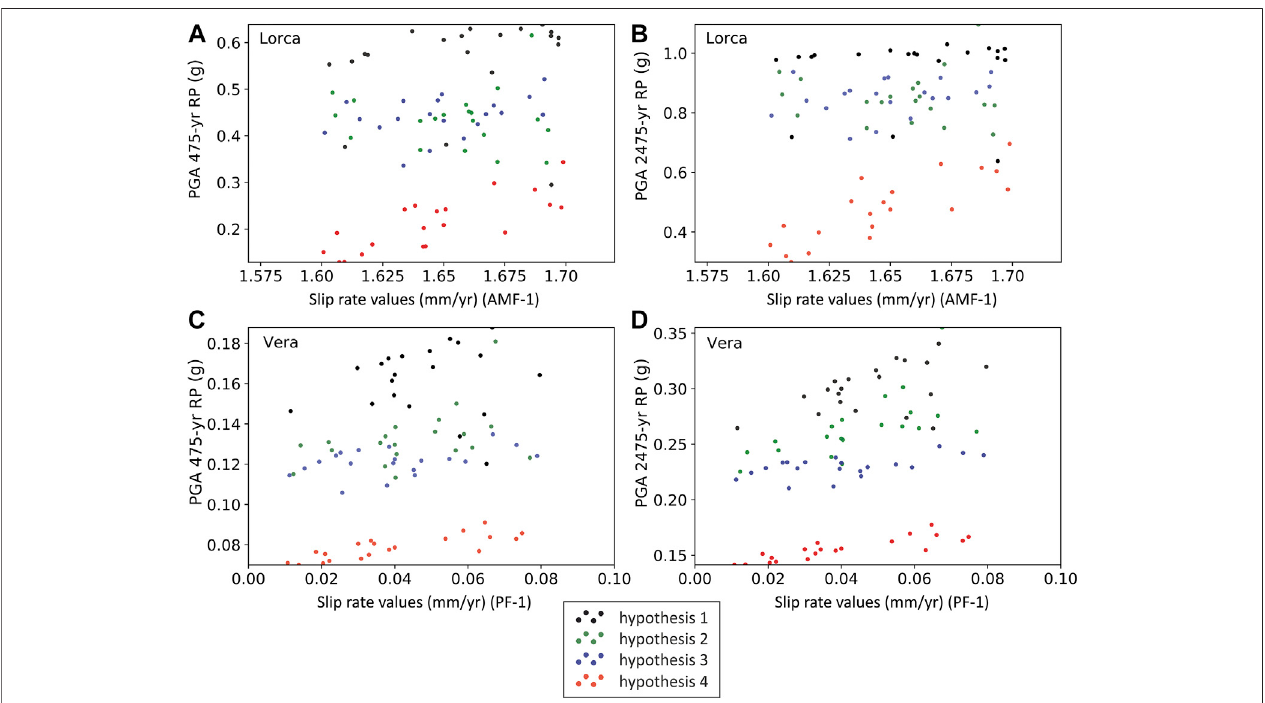
FIGURE 11 | (A) Relationship between the slip rate values of AMF-1 used in each 80 source models that compose the logic tree of this study and the respective PGA(g)valuesobtainedinthecityofLorcaforthereturnperiodsof475 yearsand; (B) 2,475 years; (C) SamerelationshipforPF-1andthePGA(g)obtainedinthecityof Veraforthereturnperiodsof475 yearsand; (D) 2,475 years.Notethatthefaultsconsideredaretheclosesttothecitiesanalyzedandsothatcanhighlightabettereffect. The source models belonging to each fault rupture hypotheses that compose the logic tree of this study are depicted in different